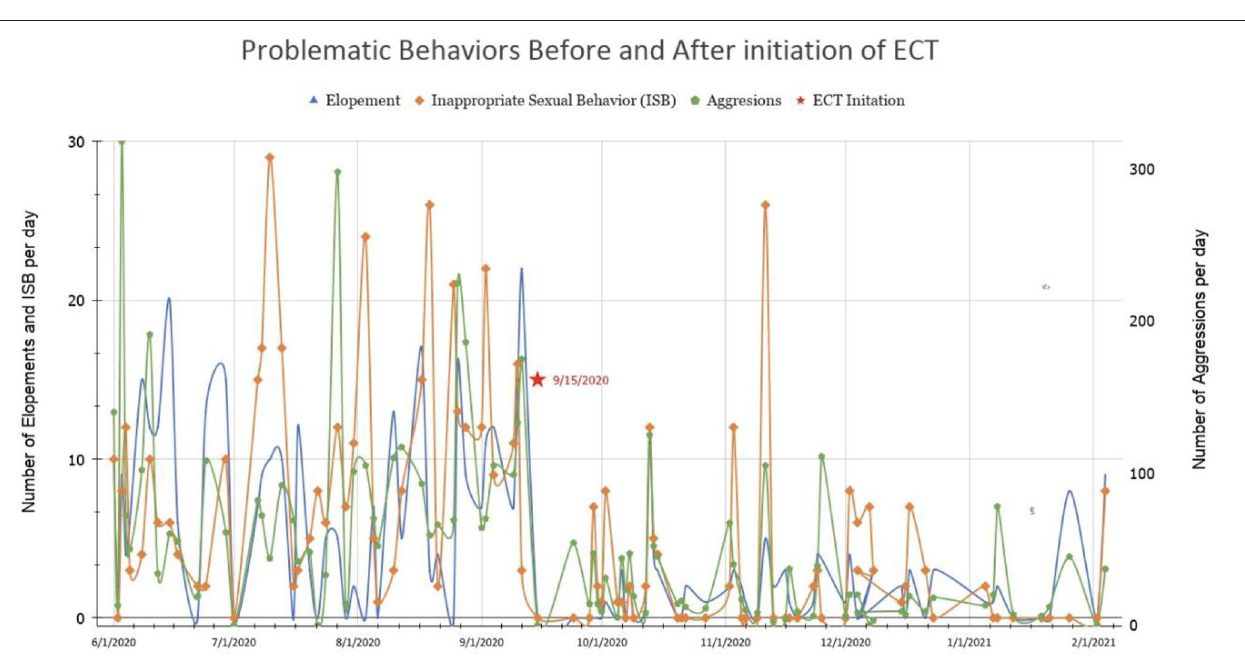
Pulse width: 0.3ms. Frequency: three treatments weekly Medication: methohexital, succinylcholine, flumazenil, midazolam First treatment: pre-treated with flumazenil 0.5mg due to lorazepam administration. The seizure was prolonged despite two doses of midazolam which were likely ineffective because the flumazenil was administered shortly before the stimulus. There were no adverse effects from the prolonged seizure.